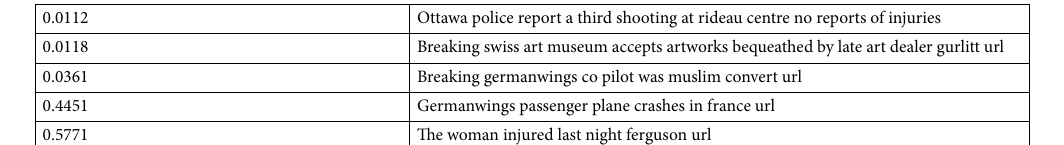
Table 7. Examples of D explain failing to predict suspicious words in some short rumors. D classify outputs probabilities in range [0, 1], where 0 and 1 represent rumor and non-rumor, respectively.